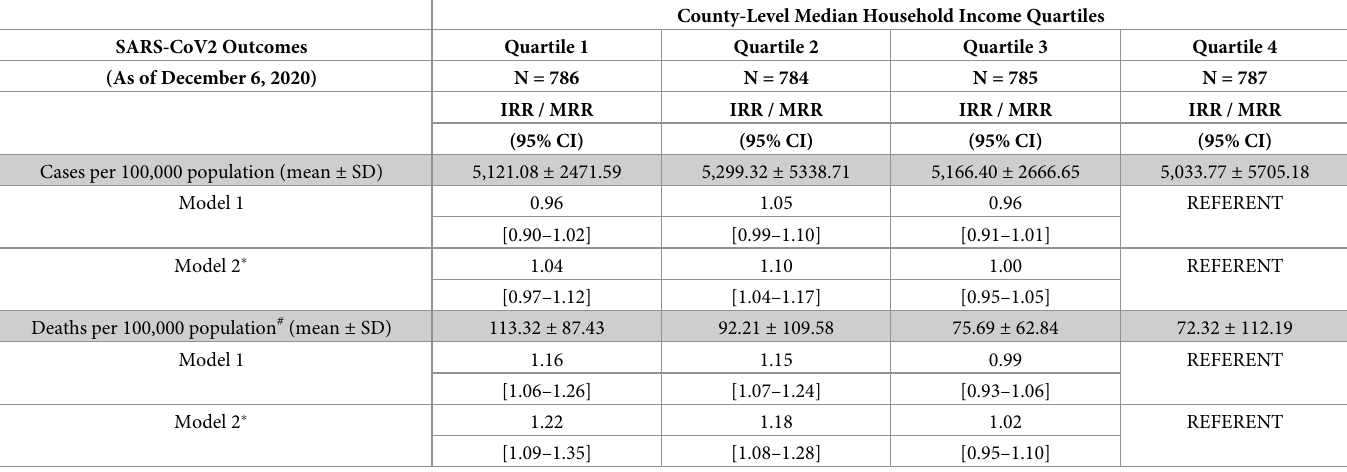
Table 2. Association of SARS-COV-2 outcomes as of December 6, 2020 with county-level median household income